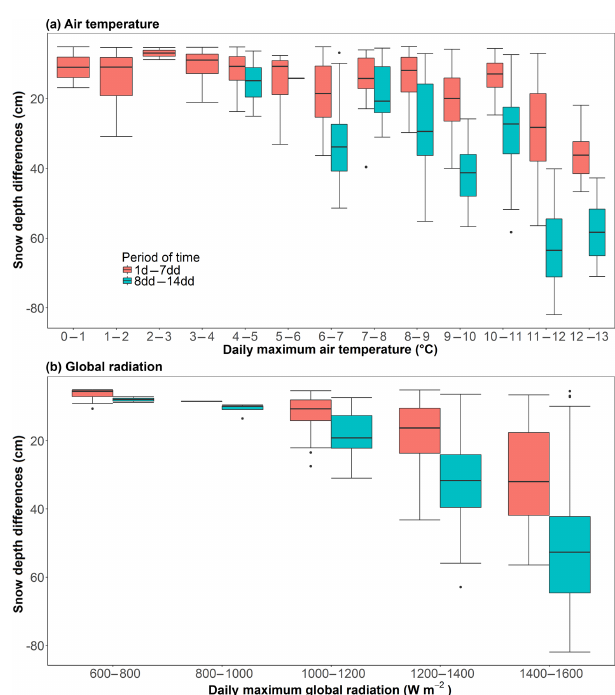
Figure 6. Box plots of environmental variables (a) daily maxi- mum air temperature and (b) daily maximum global radiation on snowmelt expressed as snow depth differences at AWS Madritsch. Snow depth differences smaller than 5cm are discarded from anal- ysis. dd refers to the days considered for